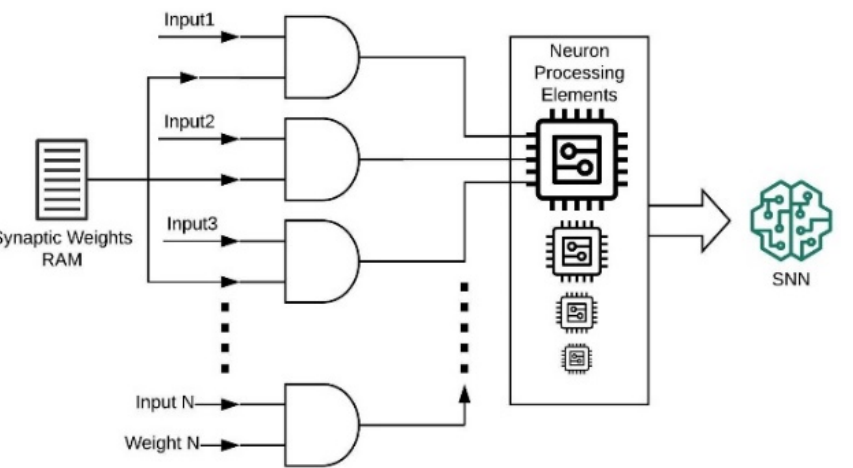
Figure 4. The combinational circuit for synaptic weight multiplication. The input RAM maintains synaptic weights that are multiplied by the input signal through the parallel AND gates.